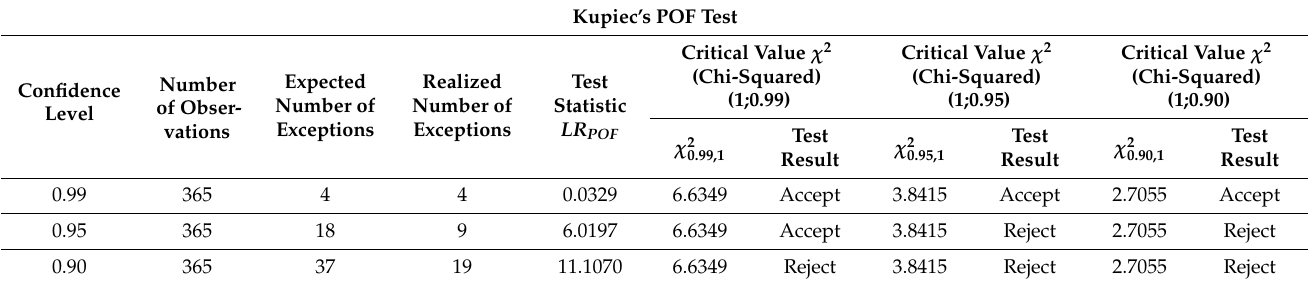
Table 6. Delta-Normal VaR Kupiec’s